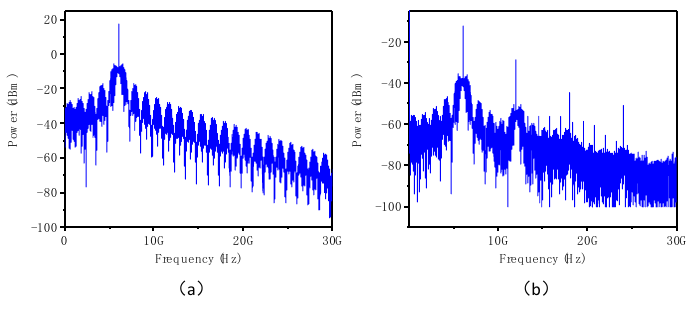
Fig.2. (a) The RF spectrum before transmission; (b) The RF spectrum after transmission.